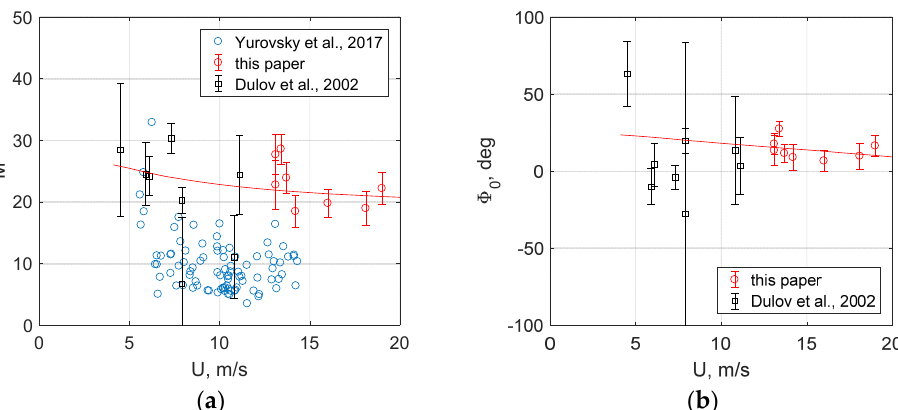
Figure 6. Modulation parameters M ( a ) and Φ 0 ( b ) as a function of wind velocity U . Symbols show data, lines show model calculations for mean-over-data ε = 0.057, α = 0.63 and model parameters n = 5 and ν = 0.5.